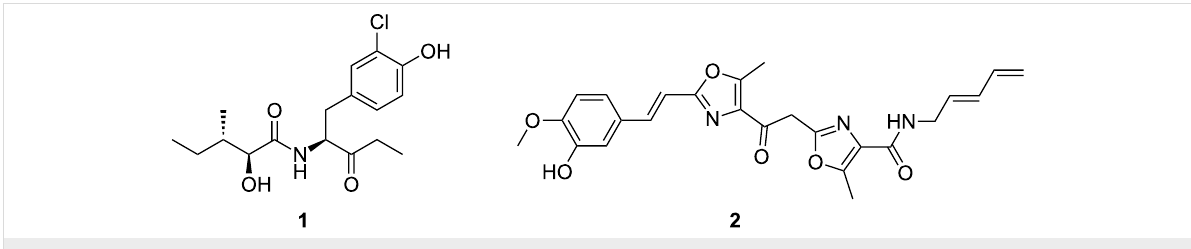
Figure 1: Herpetosiphon natural products auriculamide ( 1 ) and siphonazole ( 2 ).